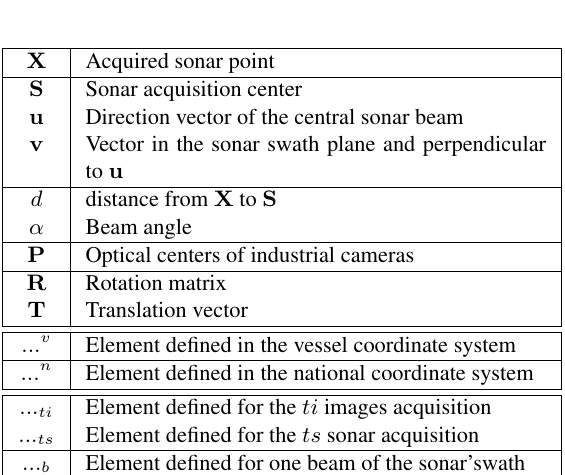
Figure 6. Definition of the coordinate system and measurement vector attached to the sonar.